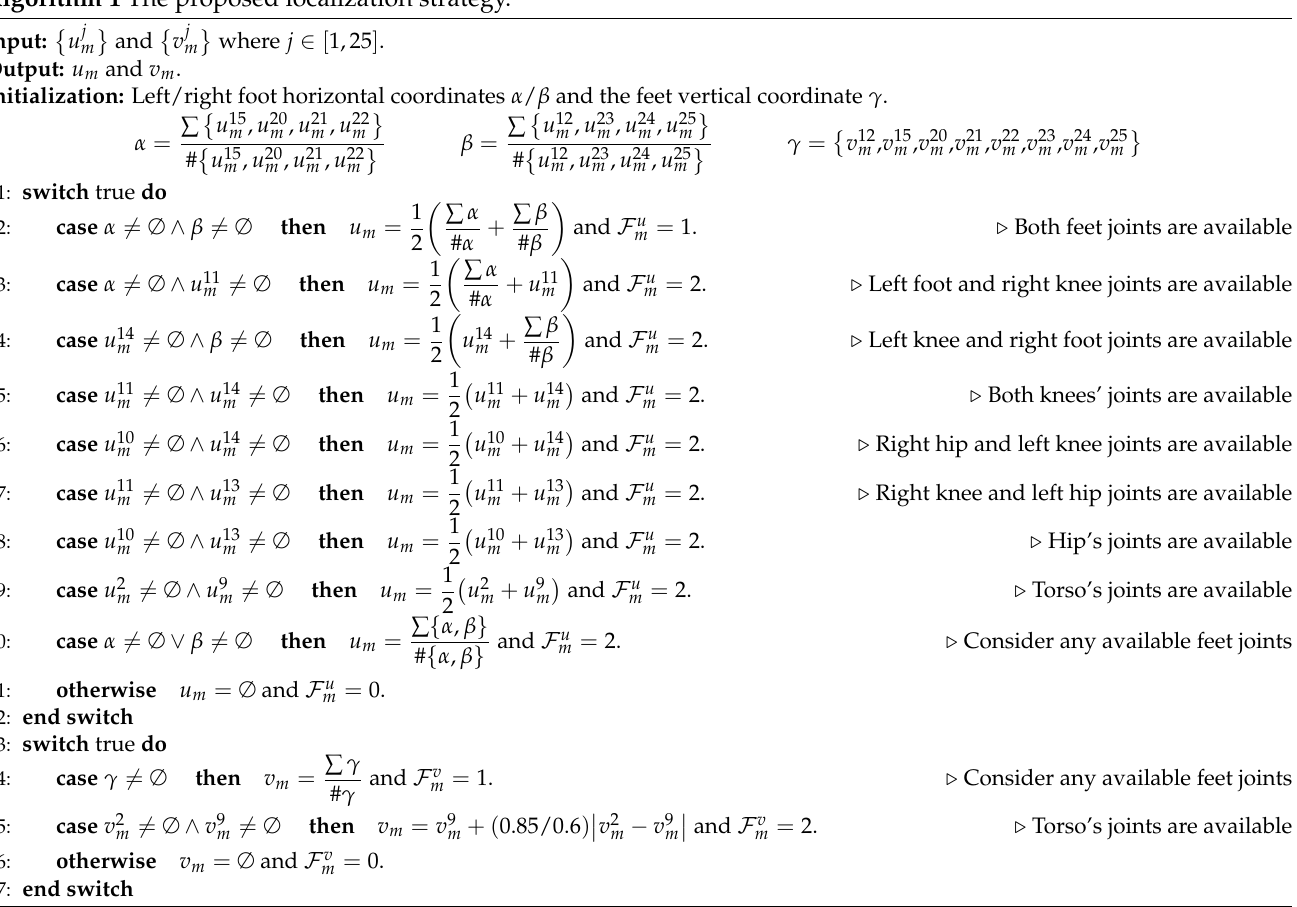
Algorithm 1 The proposed localization